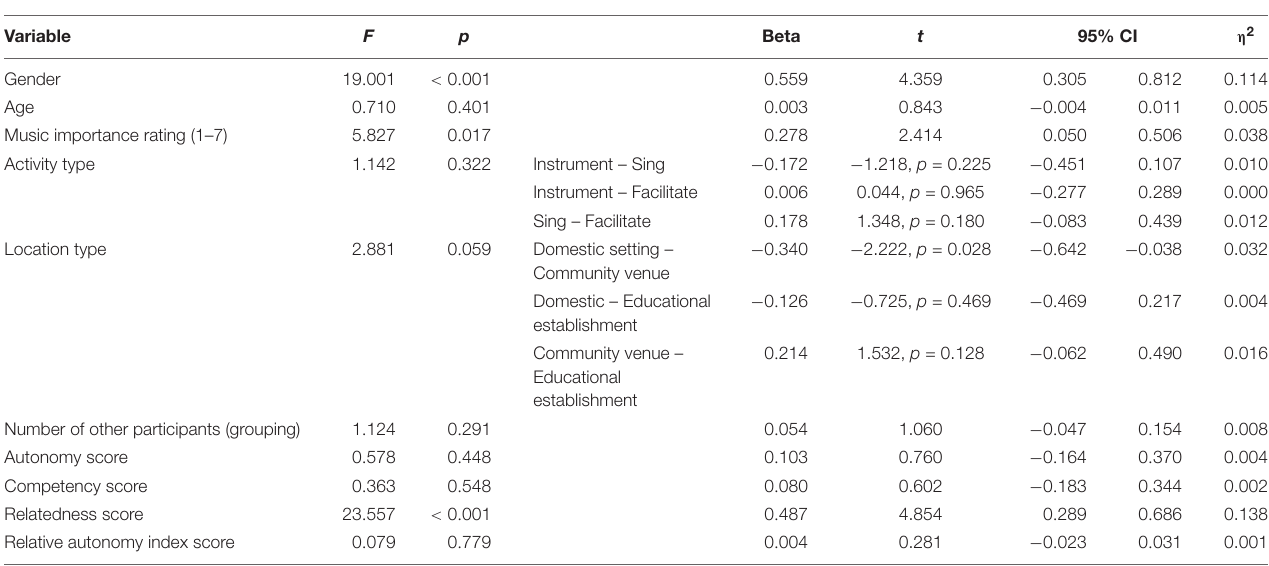
TABLE 5 | Socializing well-being score model.